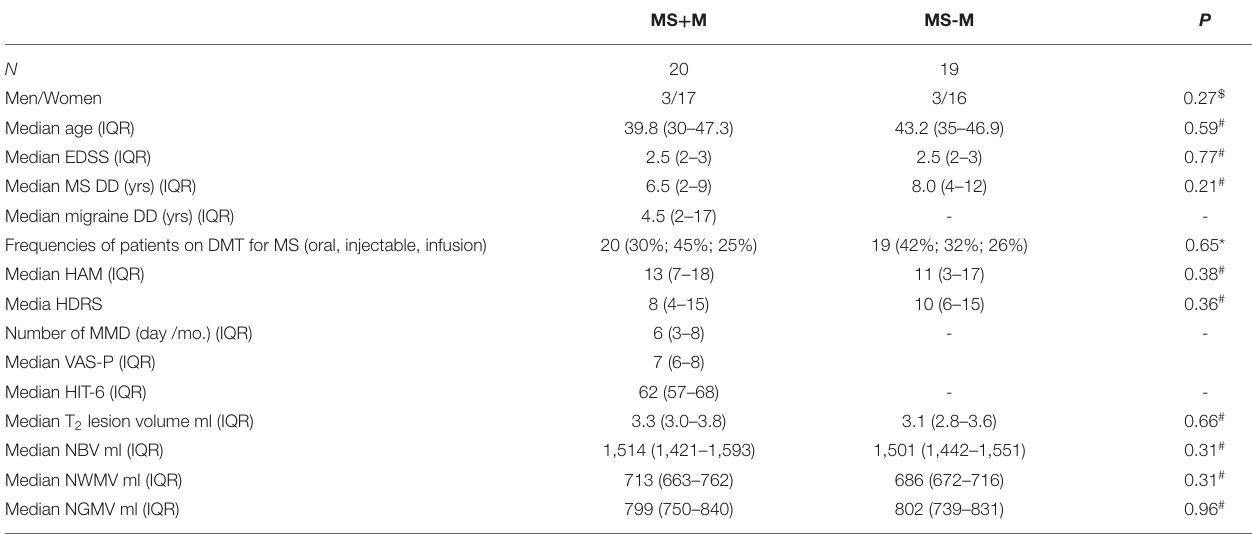
TABLE 1 | Main demographic, clinical, and structural MRI characteristics in MS + M and MS-M